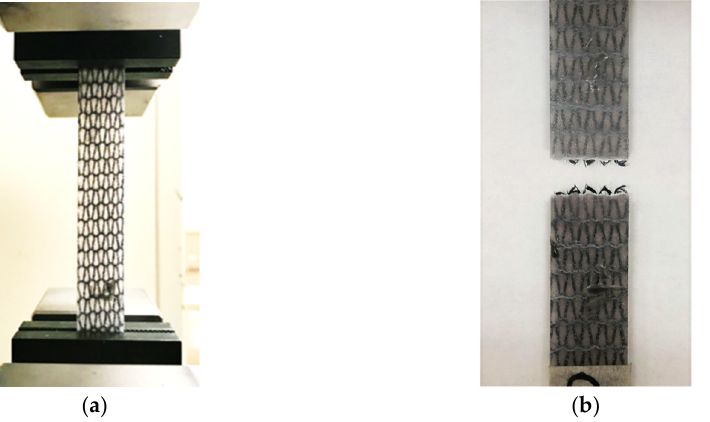
Figure 5. ( a ) The weft-knitted carbon fiber/polypropylene composite specimen during the tensile test and ( b ) a tested